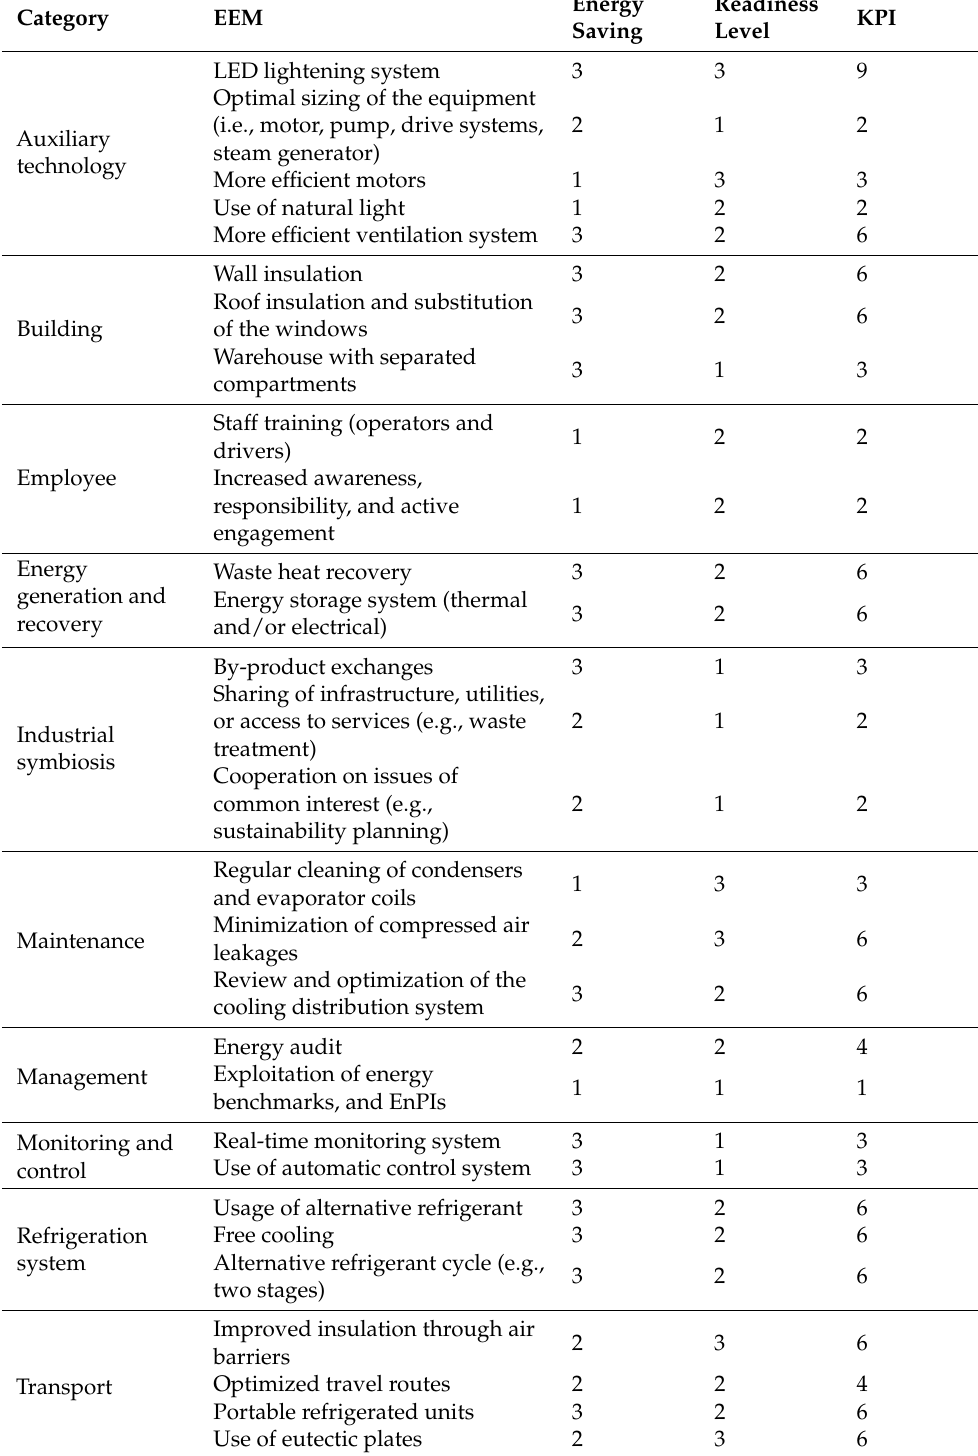
Table 1. Energy efficiency measures as best practices for cold chains. Notes: for energy saving and readiness level 1: low–3: high, for KPI 1: low potential–9: high